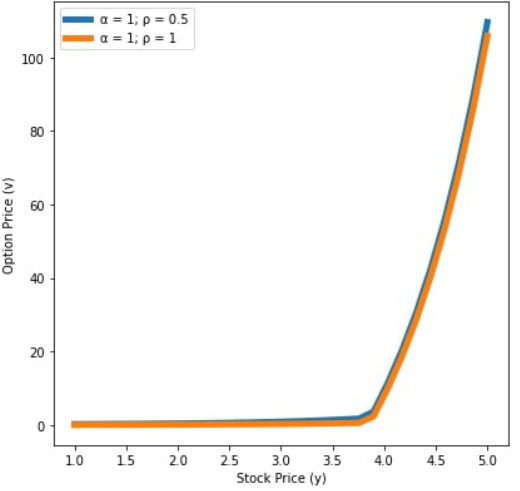
Figure 6. Values of the options for α = 1 and ρ < 1, t = 0.5 years with x = 2.3024.